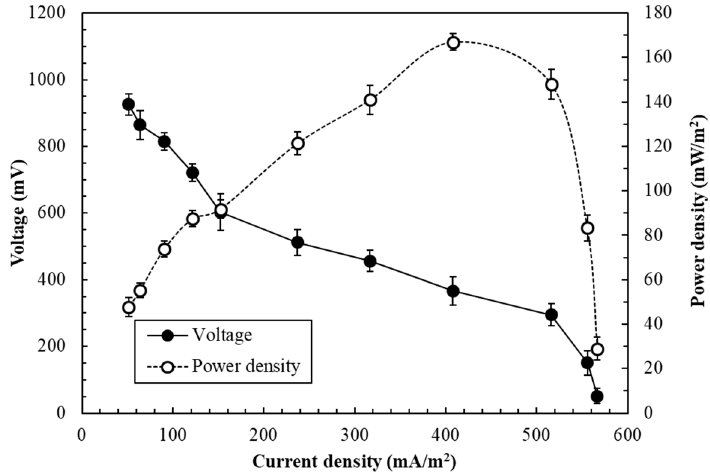
Figure 2. Curves of polarization and power density obtained in an SCMFC biosensor inoculated with E. aestuarii YC211 in the batch operation (anolyte: 1/1000 TSB supplemented with 60 mg/L Cr(VI), external resistance: 50–10,000 Ω ).